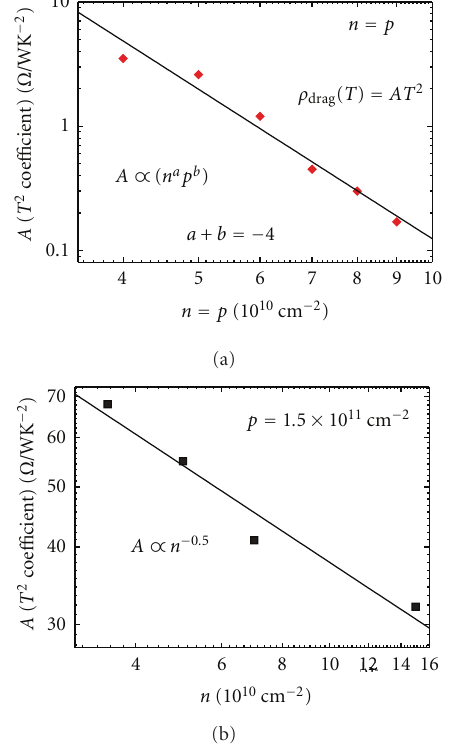
Figure 15: Fit for T 2 coe ffi cient A for ρ drag with p constant p = 1 . 5 × 10 11 cm − 2 and n varied (b) (data not shown). Same for n = p (data shown Figure in 10) (a). (Device: B138/C4-1 (a), B138/C4-2 (b) − 10 nm